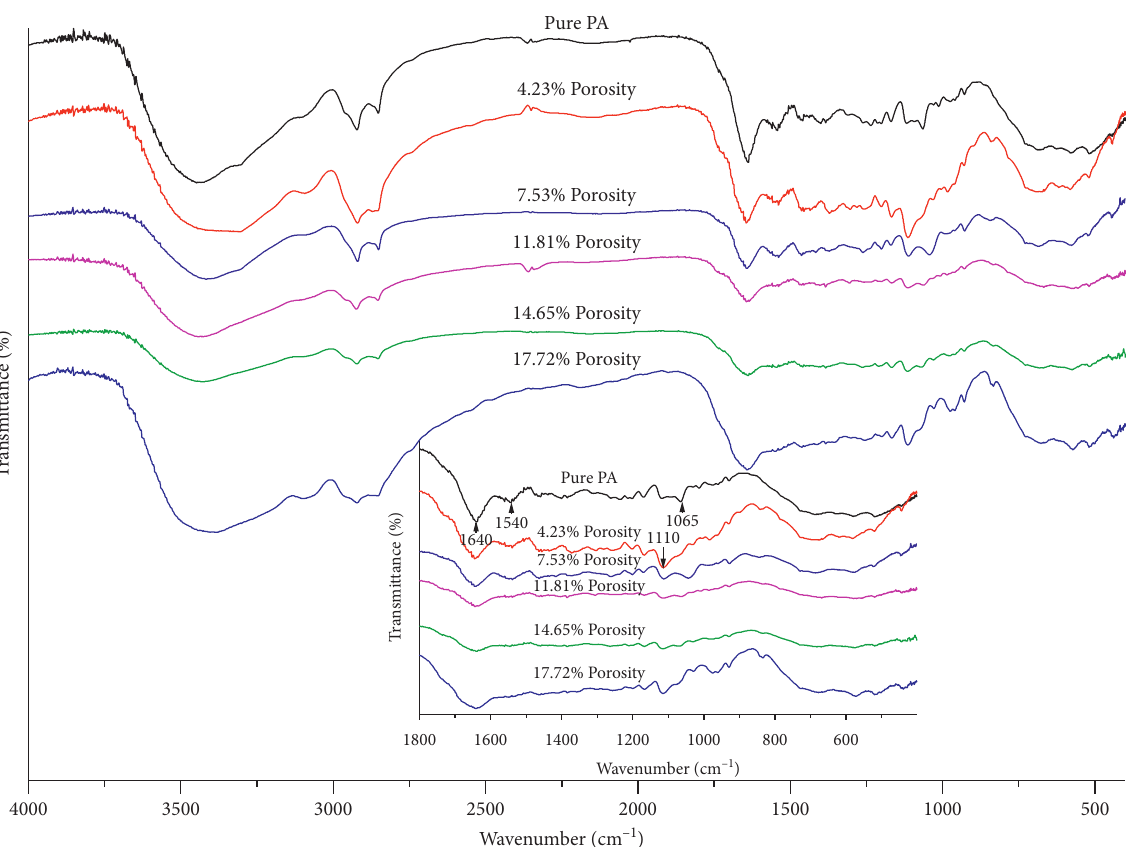
Figure 4: FTIR spectra of modified fibers with different